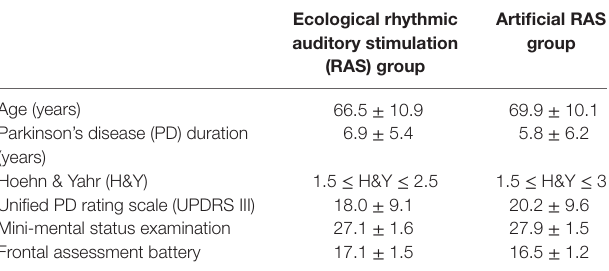
TaBlE 1 | Baseline demographic and clinical characteristics for each group.